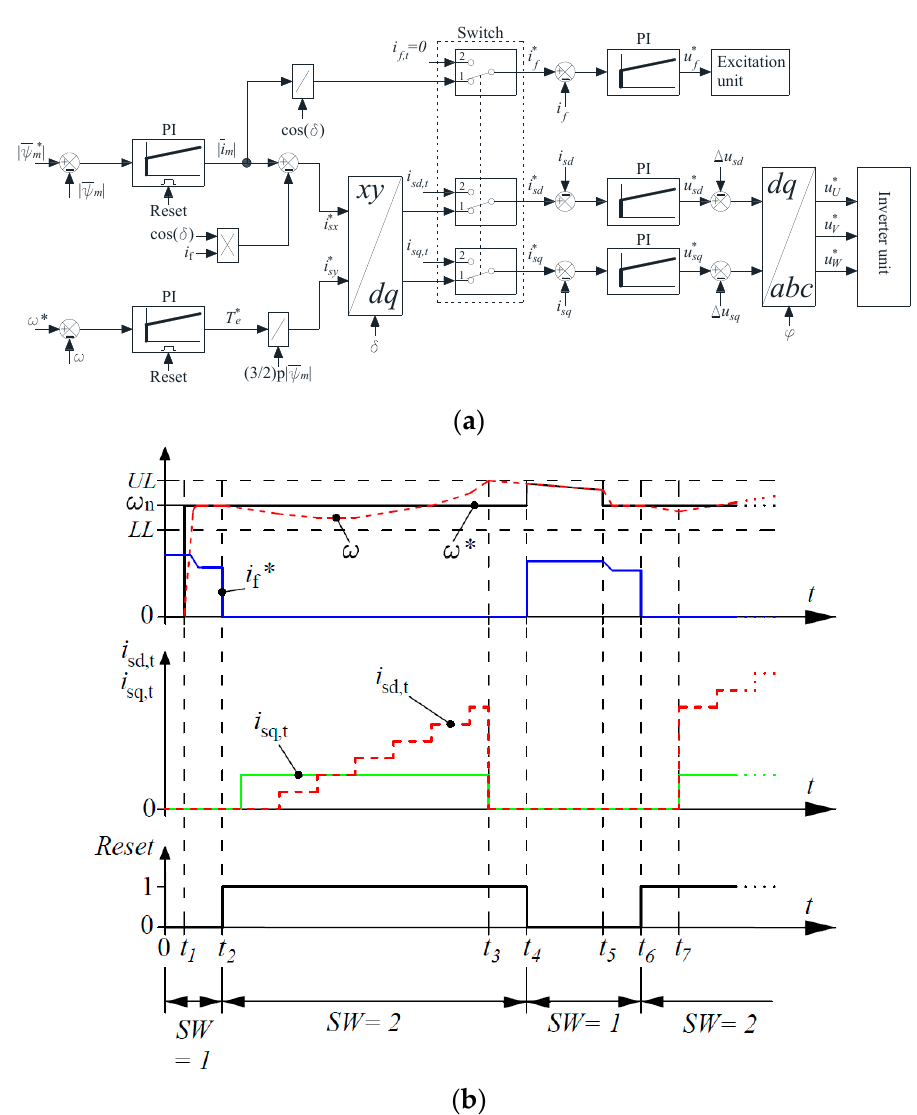
Figure 6. ( a ) FOC structure of the EESM drive modified in order to implement the proposed experimental method ( b ) signals of interest during the flux linkage map identification process. (Reference signals are denoted with the asterisk sign).